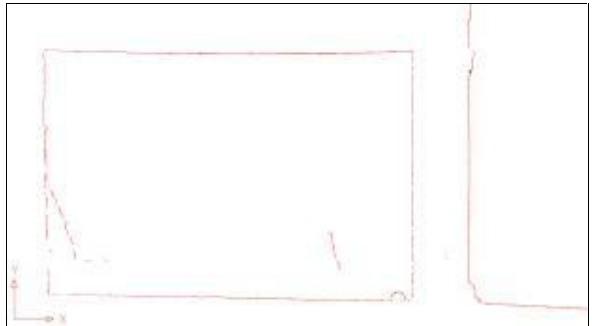
Figure 3. The high number of points needed to represent the whole geometry of a floor is too large to be used in CAD environment. A high definition raster ortho-image has been superimposed on a 1 mm point cloud silhouette in CAD, for easier measuring and tracing.